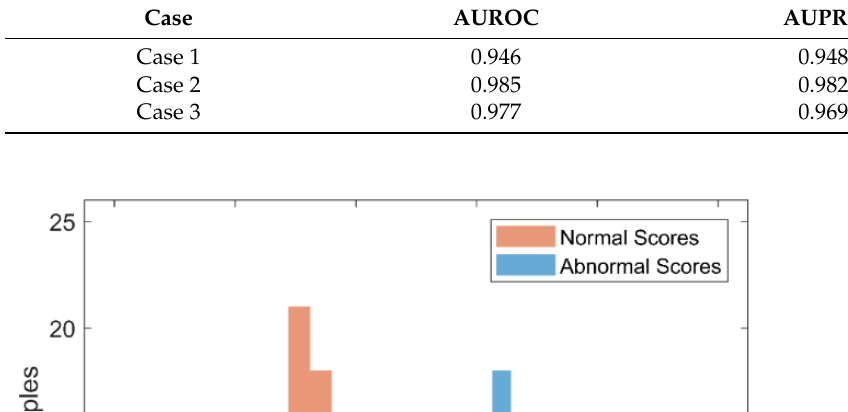
Table 5. Experimental results of our method under three input conditions.